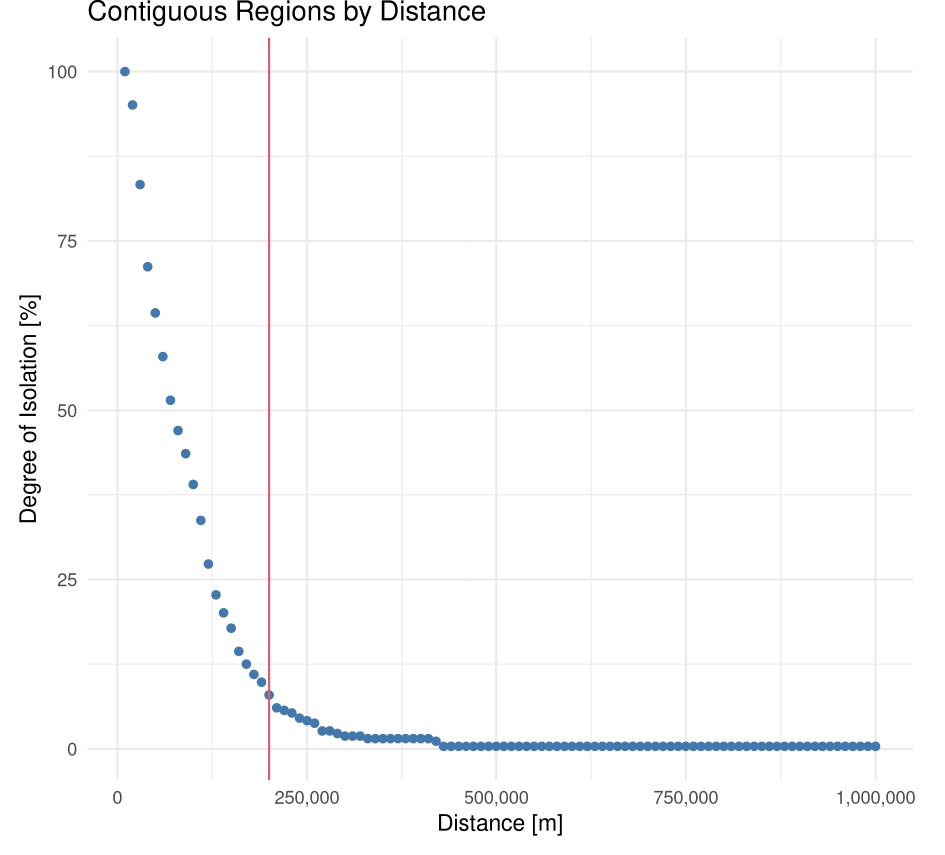
Figure 4. The degree of isolation denotes the relative number of regions that are not connected to any other. The distance was increased in steps of 10,000